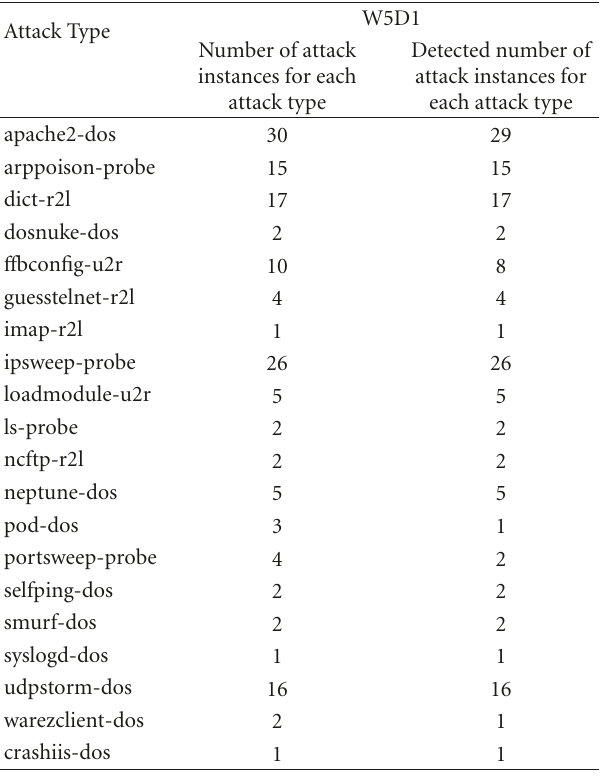
Table 4: Number of attack instances detected for each attack type for